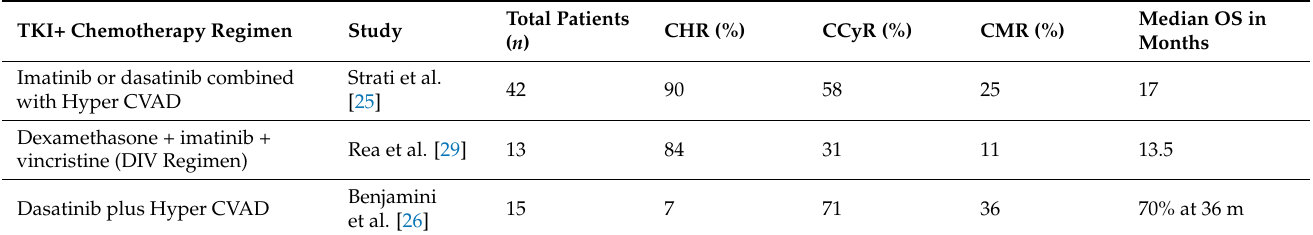
Table 2. Summary of chemotherapy plus TKI in Lymphoid Blast